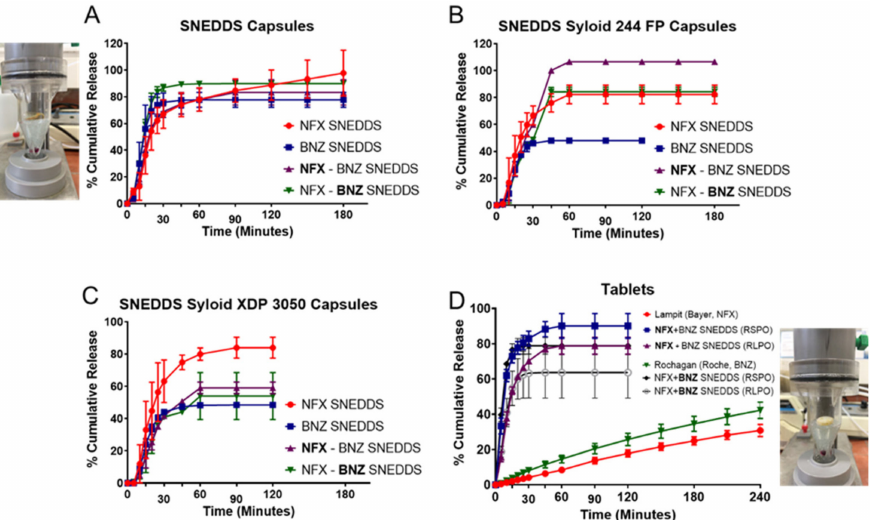
Figure 6. In vitro dissolution studies (Apparatus IV) of SNEDDS filled capsules ( A ), SNEDDS loaded in Syloid 244 FP (2:1 w / w ) and filled in capsules ( B ), SNEDDS loaded in Syloid XDP 3050 (2:1 w.w) and filled in capsules ( C ) and tablets ( D ). Key: For combined NFX-BNZ SNEDDS (0.2% NFX and 1% BNZ combined) data, the dissolution of the drug highlighted in bold is depicted (i.e., NFX -BNZ SNEDDS demonstrates the release of NFX from the combination). Significant statistical comparisons; ( B ): The % cumulative release for both NFX and BNZ from both NFX-SNEDDS and BNZ-SNEDDS loaded in Syloid 244 FP is statistically significantly lower than the % cumulative release of both drugs from the NFX-BNZ-SNEDDS loaded in Syloid 244 FP ( p < 0.05, t -test at all time points after 30 min), ( C ): The % cumulative release of NFX from both NFX-SNEDDS loaded in Syloid XDP 3050 is statistically significantly higher than the % cumulative release of NFX from the NFX-BNZ-SNEDDS loaded in Syloid XDP 3050 ( p < 0.05, t -test at all time points after 30 min), ( D ): Commercial tablets for NFX (Lampit ® ) and BNZ (Rochagan ® ) were tested versus compressed tablets of combined NFX-BNZ SNEDDS at a 2:1 w / w loaded on Syloid XDP 3050 that were overcoated with Eudragit RS PO (RSPO) or Eudragit RL PO (RLPO). The % cumulative release for both NFX and BNZ from both types of tablets is statistically significant from % cumulative release from Lampit ® and Rochagan ® tablets ( p < 0.05, Repeated measures ANOVA, post-hoc Tukey’s test at all time points up to 120